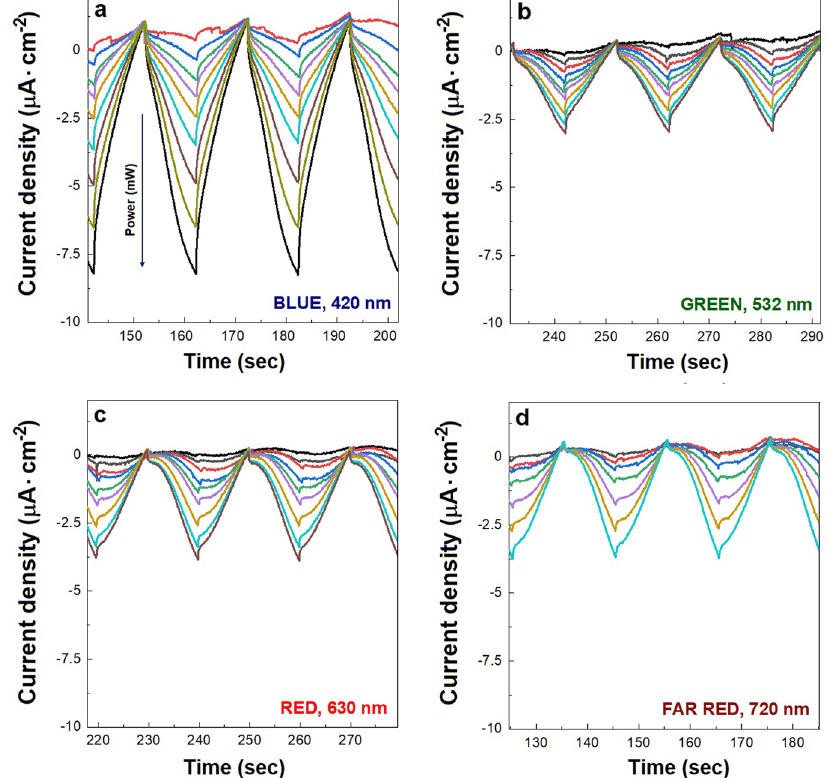
Fig. 8 TaS 2 -integrated photodetector. Power dependence of photocurrent density under the illumination of a blue (420 nm), b green (532 nm), c red (630 nm), and d far-red (720 nm) LED sources in 0.5 M H 2 SO 4 solution at 0.5 V vs. SCE. The power increased from 100 to 1200 mW: an arrow in a demonstrates the direction of power increment, which applies to all lights ( b – d